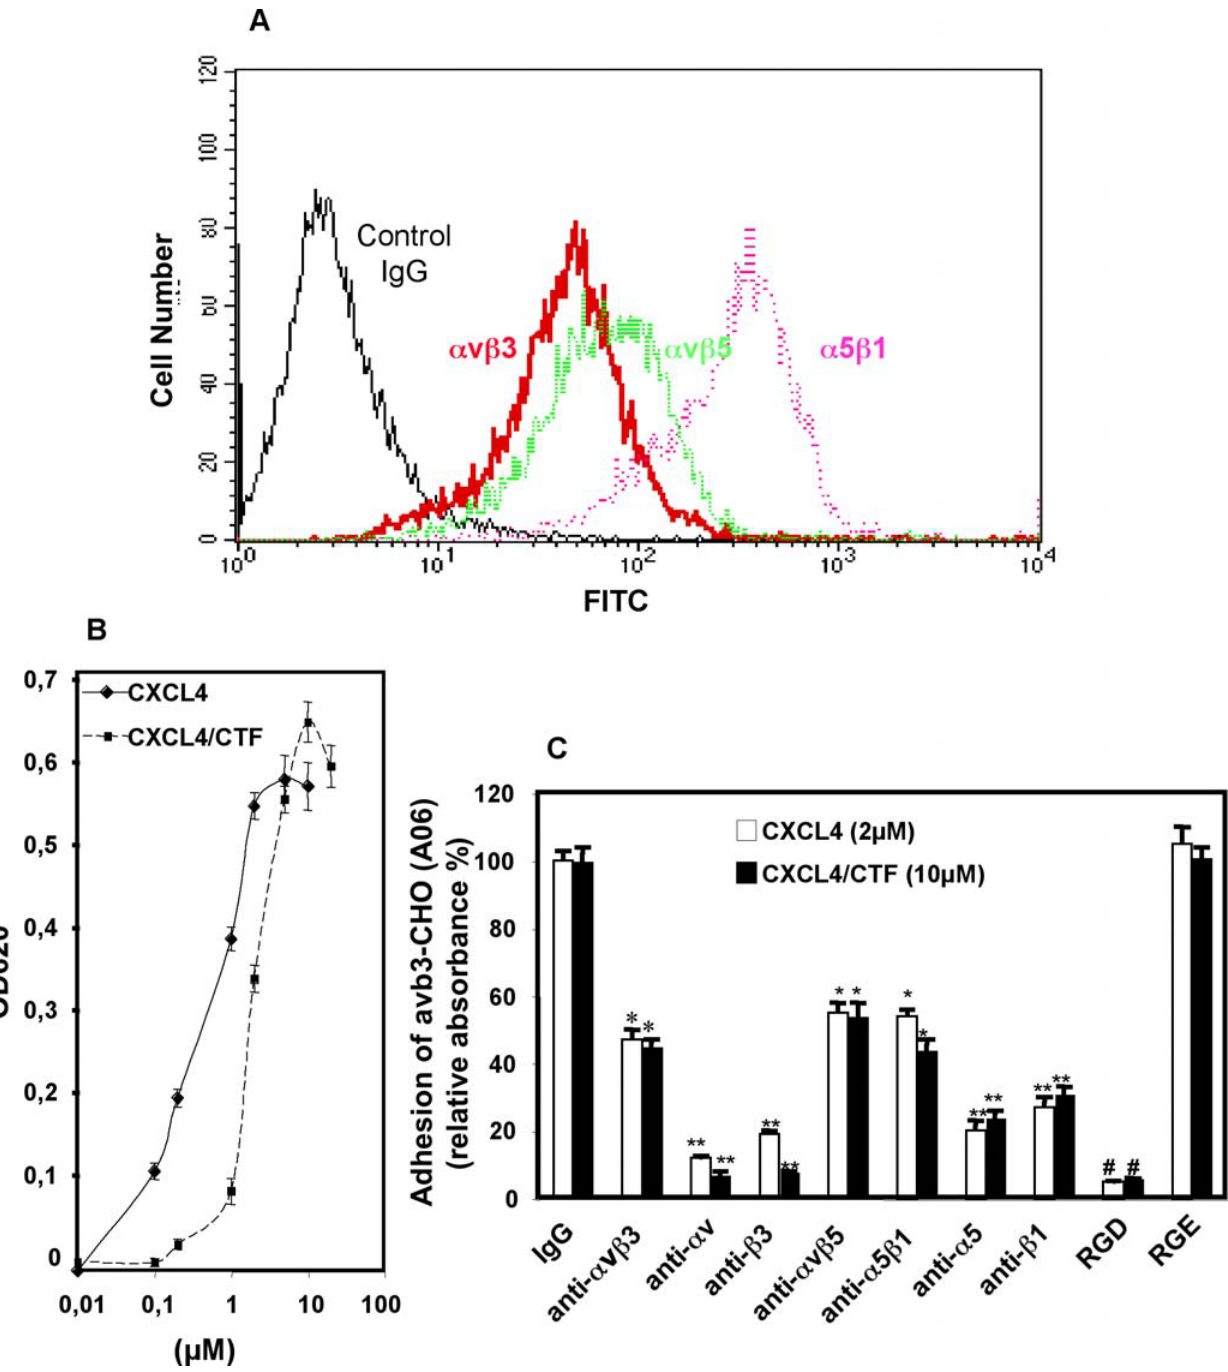
Figure 5. CXCL4-, or CXCL4/CTF-integrin mediates HUVECs adhesion through endogen a v b 3, a v b 5 and a 5 b 1 integrins. A. Expression profile of integrins in HUVECs cells analyzed by flow cytometry. HUVECs were incubated with primary antibodies specific for a v b 3 (LM609), or a v b 5 (P1F6), or a 5 b 1 (HA5) and antibody binding was detected with FITC-labeled secondary antibody as described under Materials and Methods . Cells stained with secondary antibody (2 u Ab) only were used as a negative control. B . Dose dependence of HUVECs cell adhesion to CXCL4 or CXCL4/CTF. HUVECs were plated onto microtiter wells coated with the indicated concentrations of CXCL4 or CXCL4/CTF and cell attachment was analyzed as described in Material and Methods C . Cell adhesion to CXCL4 and CXCL4/CTF is a v b 3, a v b 5 and a 5 b 1 integrins dependent. Cells were incubated with the indicated antibodies or RGD-, RGE peptides before plating to wells coated with CXCL4 or CXCL4/CTF. Anti-integrin antibodies used were: anti- a v b 3 (LM609), anti- a v ( A V1), anti- b 3 (B3A), anti- a v b 5 (P1F6), anti- a 5 b 1 (JBS5), anti- a 5 (P1D6) and anti- b 1 (CD29). Cell attachment was analyzed as above. Error bars represent the mean 6 SD, *, P # 0.001; **, P # 0,0001; # , P # 0,00001 compared to CXCL4 or CXCL4/CTF in the presence of IgM control antibody; n=4 independent experiments.